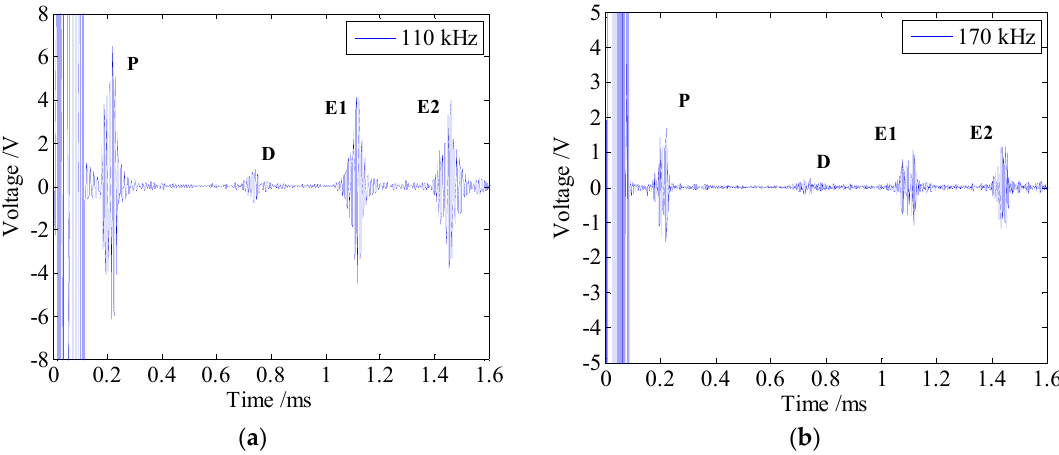
Figure 14. The testing signals received by the EMAT with one permanent magnet chain at the frequencies of ( a ) 110 kHz ( b ) 170 kHz.